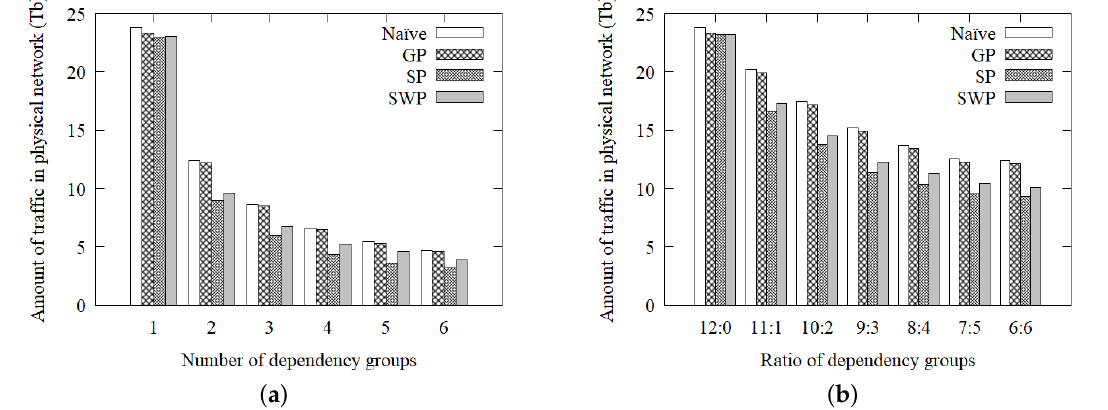
Figure 11. Effect of the number and ratios of dependency groups: ( a ) effect of the number of dependency groups on the amount of data traffic; and ( b ) effect of the distribution of VMs to the dependency groups on the amount of